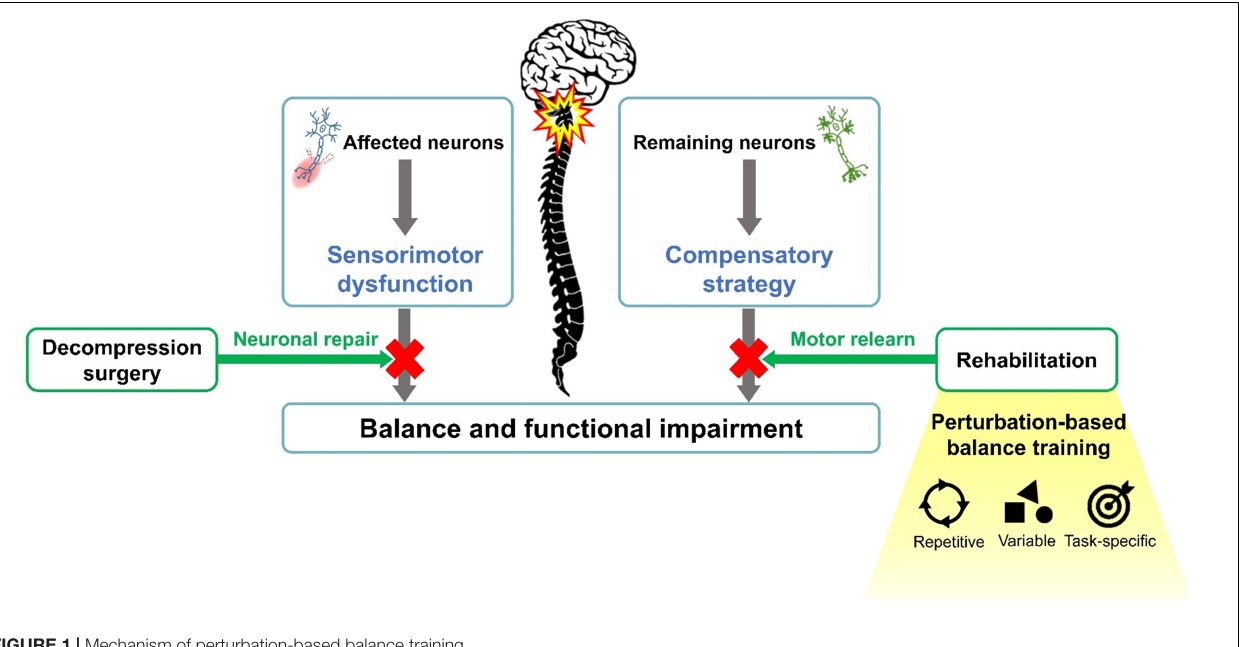
FIGURE 1 | Mechanism of perturbation-based balance